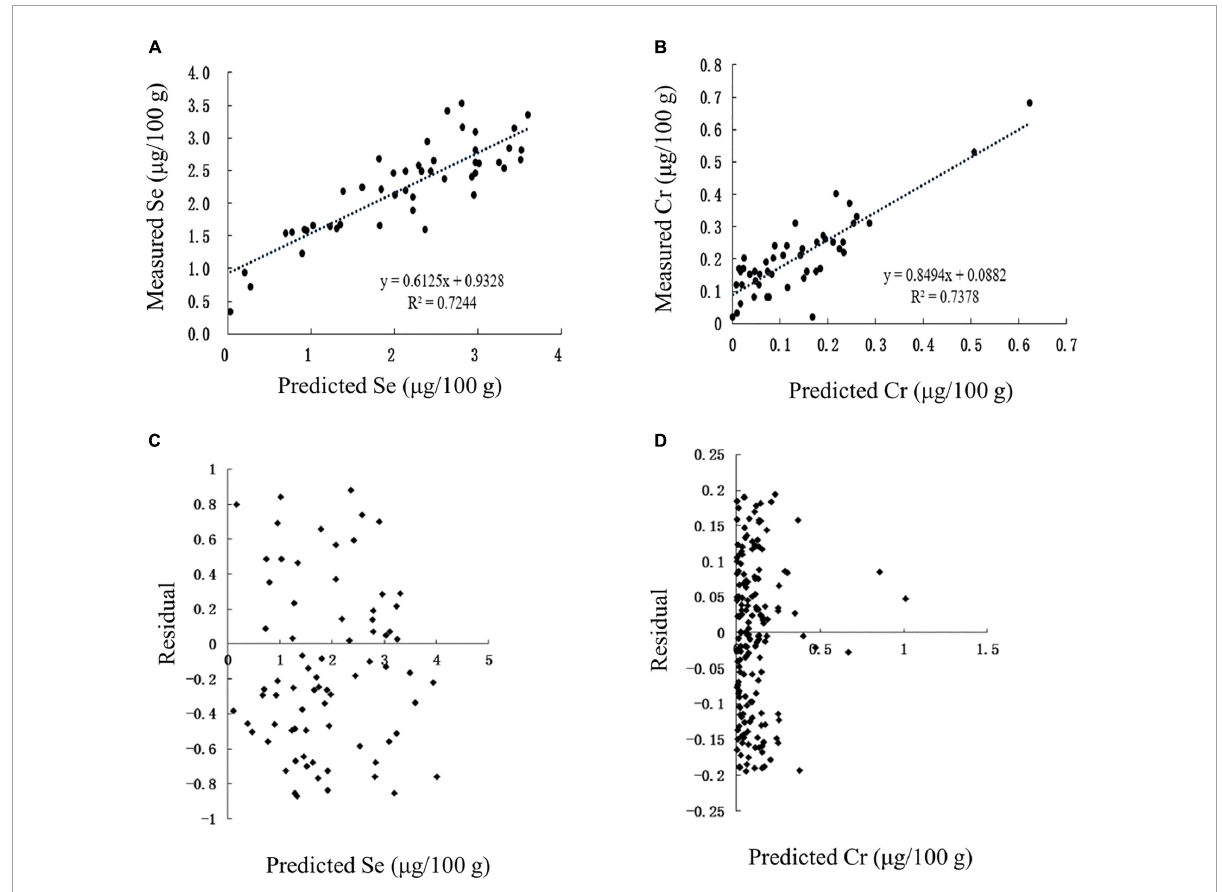
FIGURE10 Validation of prediction models in Se-rich egg. (A,B) Correlation between the predicted and measured Se and Cr contents, respectively. (C,D) Residual analysis of the fitted and measured Se and Cr contents,